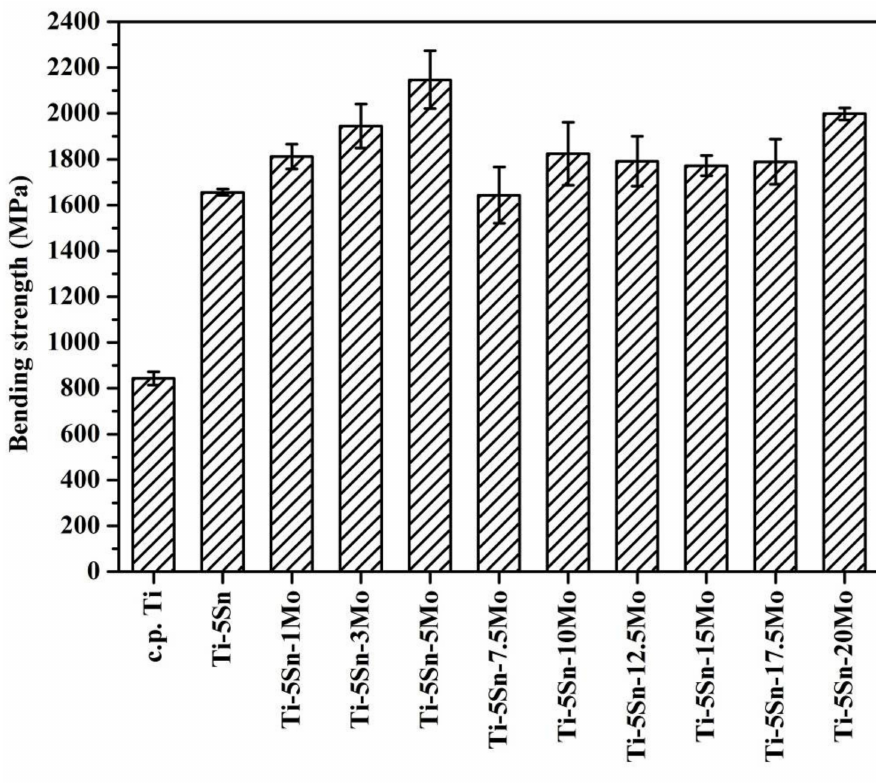
Figure 4. Bending strengths of as-cast c.p. Ti, Ti–5Sn, and Ti–5Sn– x Mo